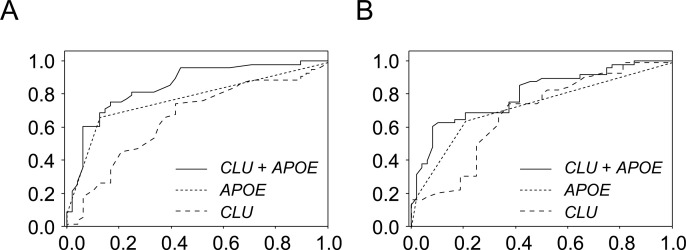
ROC results for classifying control and AD subjects.ROC analyses using either methylation rates at the CpG island shore of CLU (long dashed line), the number of the APOE ε4 allele (short dashed line), or the combination of both (solid line). A plot of ROC results from the replication group (A). The AUCs obtained were 0.66 for the methylation rate only (95% CI: 0.55–0.77), 0.78 for the APOE ε4 allele number only (95% CI: 0.68–0.87), and 0.85 for both (95% CI: 0.77–0.93). The model developed from the replication group was applied to the test group to draw another ROC plot (B). The AUCs obtained were 0.69 for the methylation rate only (95% CI: 0.56–0.80), 0.73 for the APOE ε4 allele number only (95% CI: 0.63–0.83), and 0.80 for both (95% CI: 0.71–0.89). ROC plots represent sensitivity (i.e., true positive rate) versus 1-specificity (i.e., false positive rate). Abbreviations: ROC, receiver operating characteristic; AD, Alzheimer’s disease; AUC; area under the curve; CI, confidence interval.